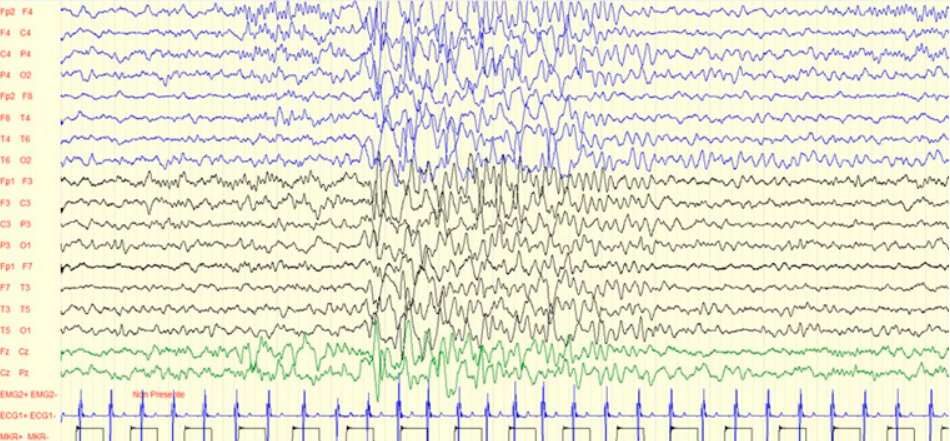
Figure 4. EEG anomalies (diffuse slow waves) of the same case in Figure 3. Table 2. Characteristics of Group